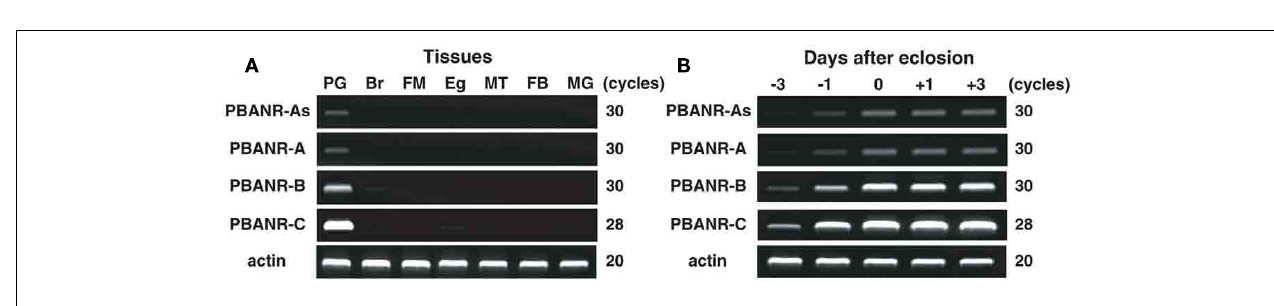
FIGURE 3 | Expression profile of BommoPBANR transcripts in adult female tissues. (A) Expression in adult tissues.Tissues were dissected from newly emerged (day 0) p50 female moths. PG, pheromone gland; Br, brain; FM, flight muscle; Eg, unfertilized egg; MT, Malpighian tubule; FB, fat body; MG, midgut. (B) Expression in the PG at different